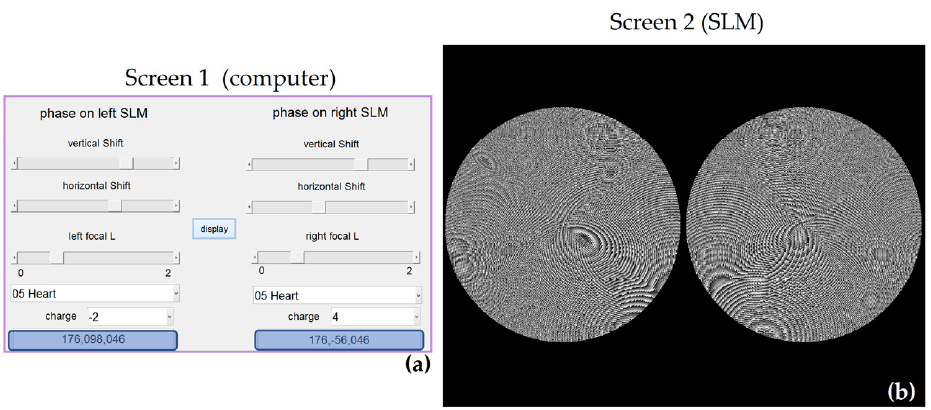
Figure 3. Encoding of phase patterns for beam shaping, ( a ) Computer interface, and ( b ) phase pat ‐ terns displayed on the SLM.